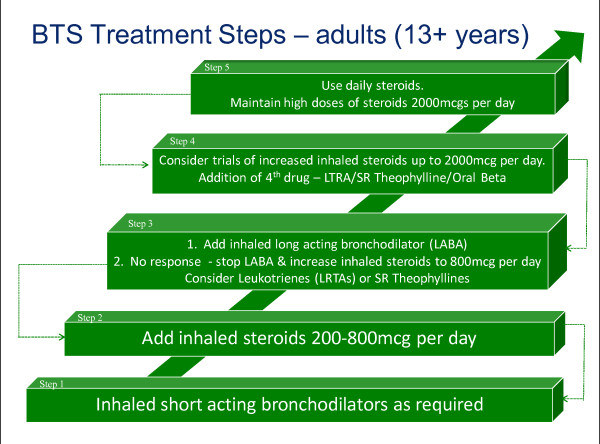
British Thoracic Society/SIGN Treatment Steps for Asthma (13+ years).